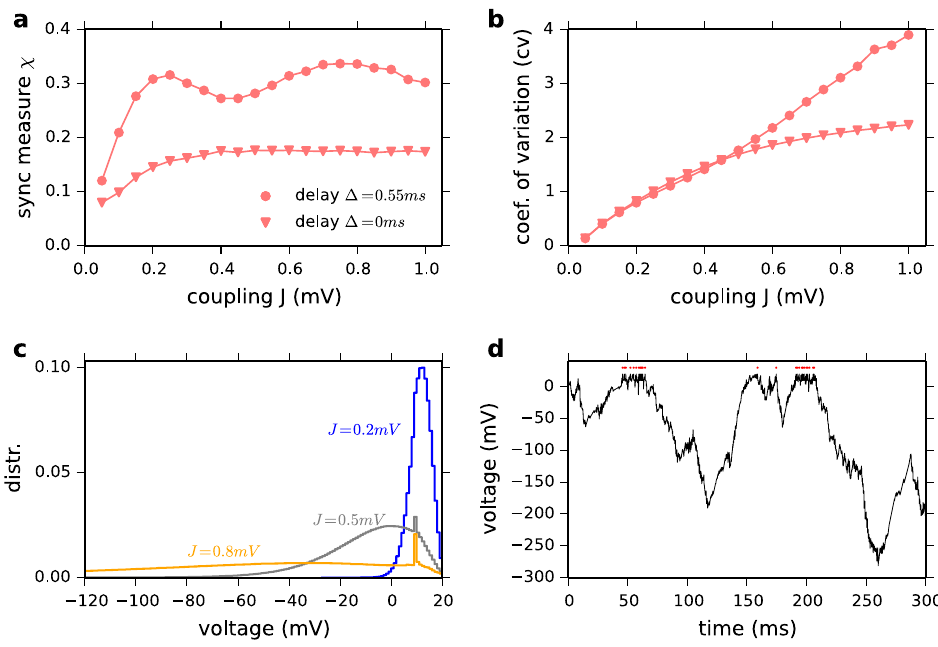
Figure 2. ( a ) Synchrony measure X vs. coupling strength J. Dots: Δ =0.55 ms. Triangles: Δ =0.0 ms for N=10000, C=1000. X is defined as in (Hansel & Mato, 2003) on the phases of neurons. Note that zero delay does not increase network synchrony. ( b ) Coefficient of variation of the interspike intervals vs. coupling strength J. ( c ) Distribution of membrane potentials for different coupling strength J (in mV). ( d ) Example voltage trace for J=0.8 mV shows very negative excursions followed by short bursts of action potentials. Red dots indicate spike times. Numerically exact event-based simulation were implemented in Julia programing language. Other parameters are chosen as in (Ostojic,